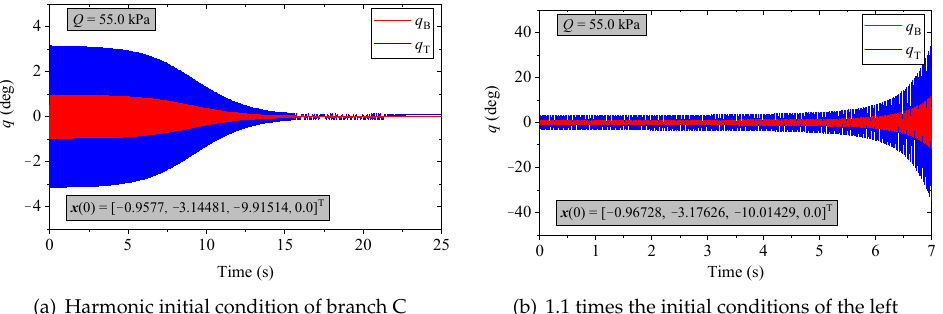
Figure 21. Time-domain responses of the system with different initial conditions at δ B / δ T = 0.1. The phase parameter φ c of the harmonic initial condition is set to π /2).